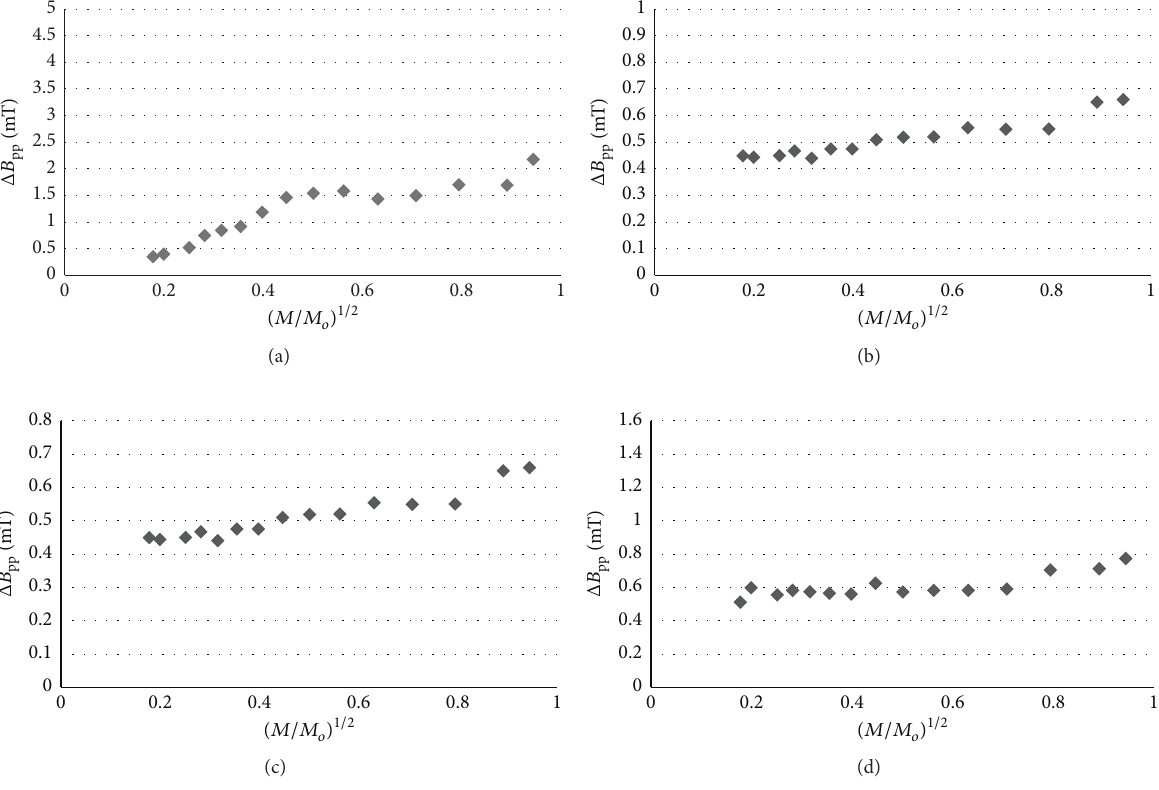
(3) Fast spin-lattice relaxation existed in UV irradiated salicylic acid and urea. (4) Free radicals formed by UV irradiation may interact with skin during therapy. (5) Because of free radicals production via photolysis salicylic acid and urea should not be stored under UV